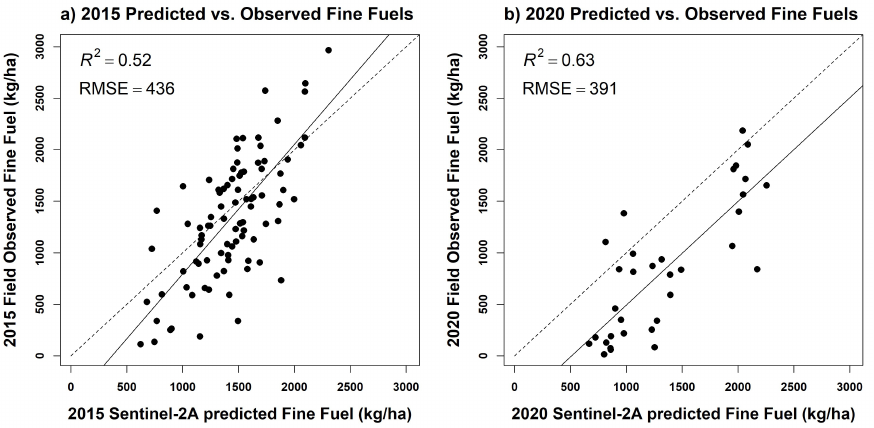
Figure 3. Validation of Sentinel-2A models of predicted fine-fuels (kg/ha) vs. observed field estimates of fine-fuels (kg/ha) for ( a ) 2015 validation test data ( n = 90) and ( b ) 2020 validation data ( n = 35) using general linear models (solid line); 1:1 line forced through the origin (dashed line) shown for reference. c. Figure 4—fine fuel values are 2 ×